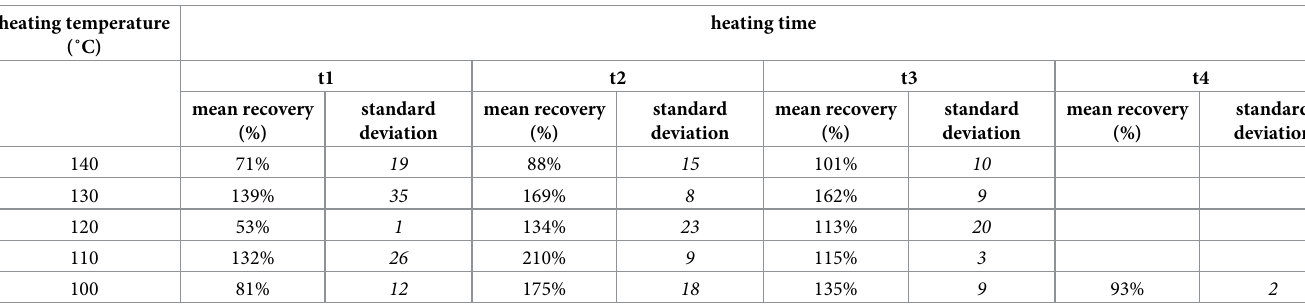
Table 2. Genomic DNA